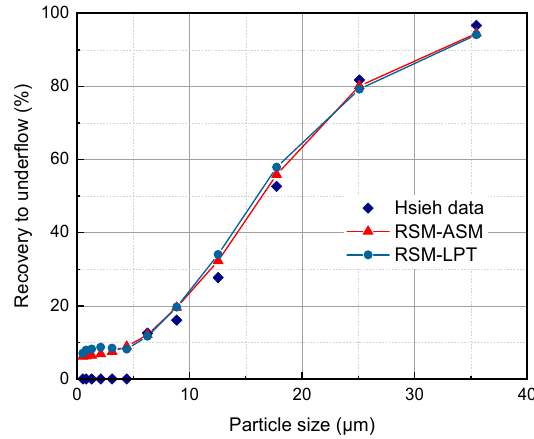
Figure 5. Comparison of particle size distribution in products of the Φ 75 mm hydrocyclone. ( a ) — Overflow product; ( b ) — Underflow product